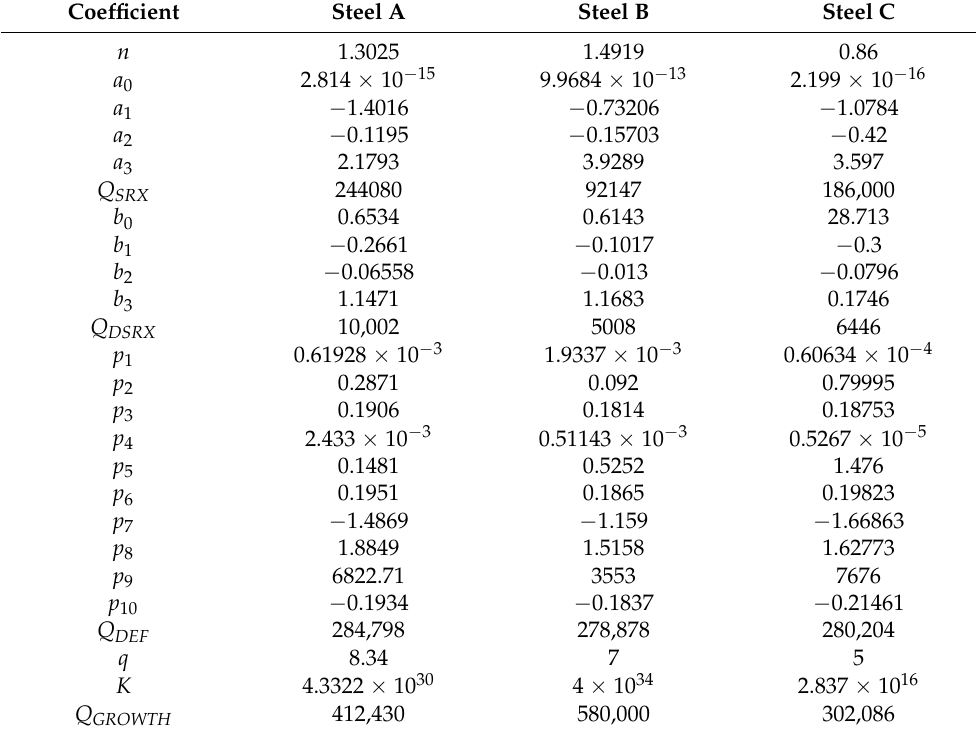
Table 5. Coefficients in microstructure equations for the investigated